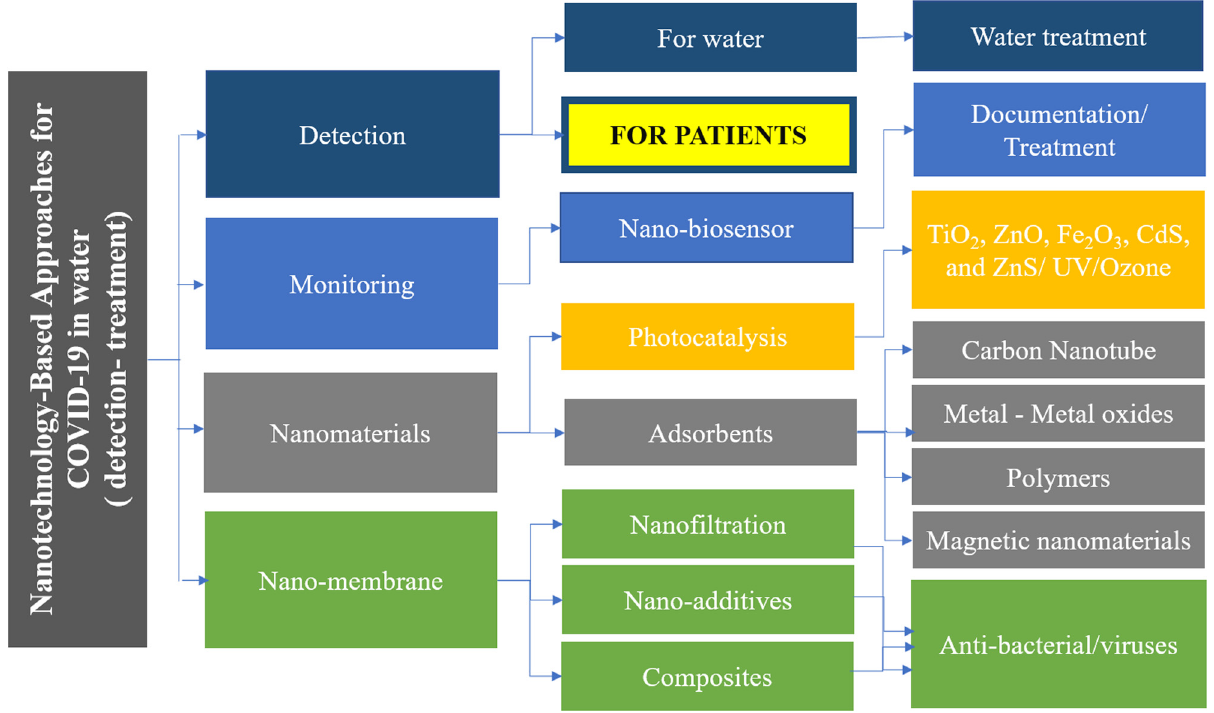
Figure 11: Nanotechnology - based approaches for COVID - 19 in water ( detection/ treatment )